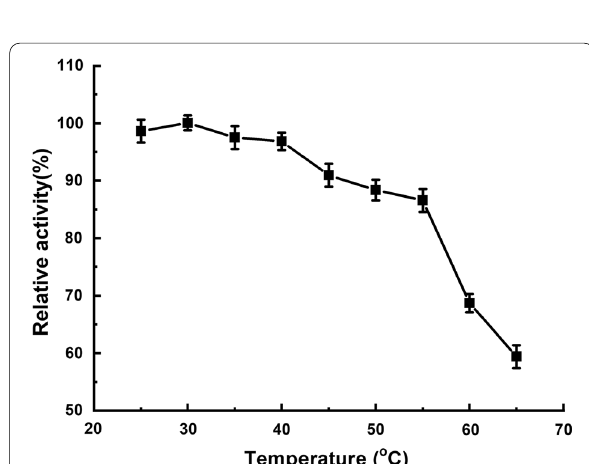
Fig. 5 Effect of temperature on activity of esterase Tan410